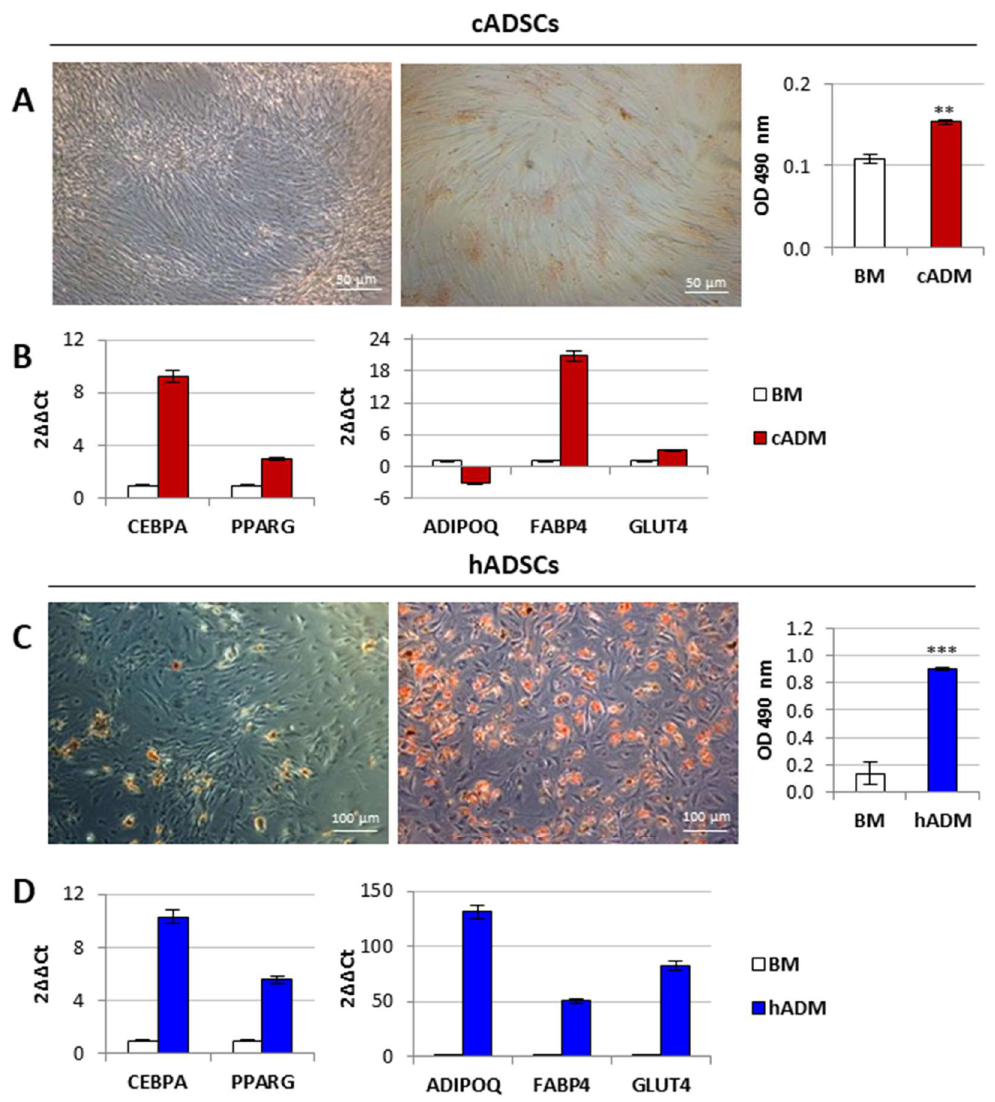
Figure 6. In vitro adipogenic differentiation potential of cADSCs and hADSCs. ( A , C ) Oil Red O (ORO) staining and quantification of lipid droplets in cADSCs (magnification 20 × ) and hADSCs (magnification 10 × ) after 21 and 14 days of adipogenic differentiation, respectively, in adipogenic differentiation medium (ADM). Data are expressed as mean ± SD ( n = 3). ** p < 0.01, *** p < 0.001 indicate statistically significant difference compared to cells grown in BM. ( B , D ) Gene expression profiles of the adipogenic markers ADIPOQ, CEBPA, FABP4, GLUT4, and PPARG in cADSCs and hADSCs,